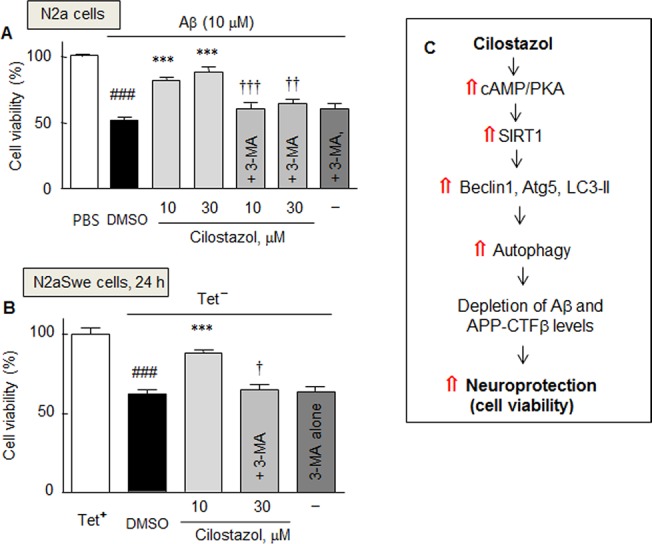
Effect of cilostazol on Aβ-induced cytotoxicity.Decrease in cell viability in response to exogenous Aβ1–42 in N2a cells (A) and to endogenously overproduced Aβ in the N2aSwe cells (B), and the recovery by cilostazol in the absence and presence of 3-methyladenine (3-MA, 2.5 mM). Results are the means ± SDs of three experiments. ###
P < 0.001 vs. PBS (A) and Tet- condition (B); ***P < 0.001 vs. DMSO; †
P < 0.05, ††
P < 0.01, †††
P < 0.001 vs. 10 or 30 μM cilostazol alone. PBS, phosphate-buffered saline. C. Hypothetical model: Neuroprotective effect of cilostazol against Aβ-induced neurotoxicity is ascribable to the increased induction of autophagy by increasing the cAMP/PKA coupled SIRT1 activation, thereby enhances Aβ and CTFβclearance and increases cell viability.